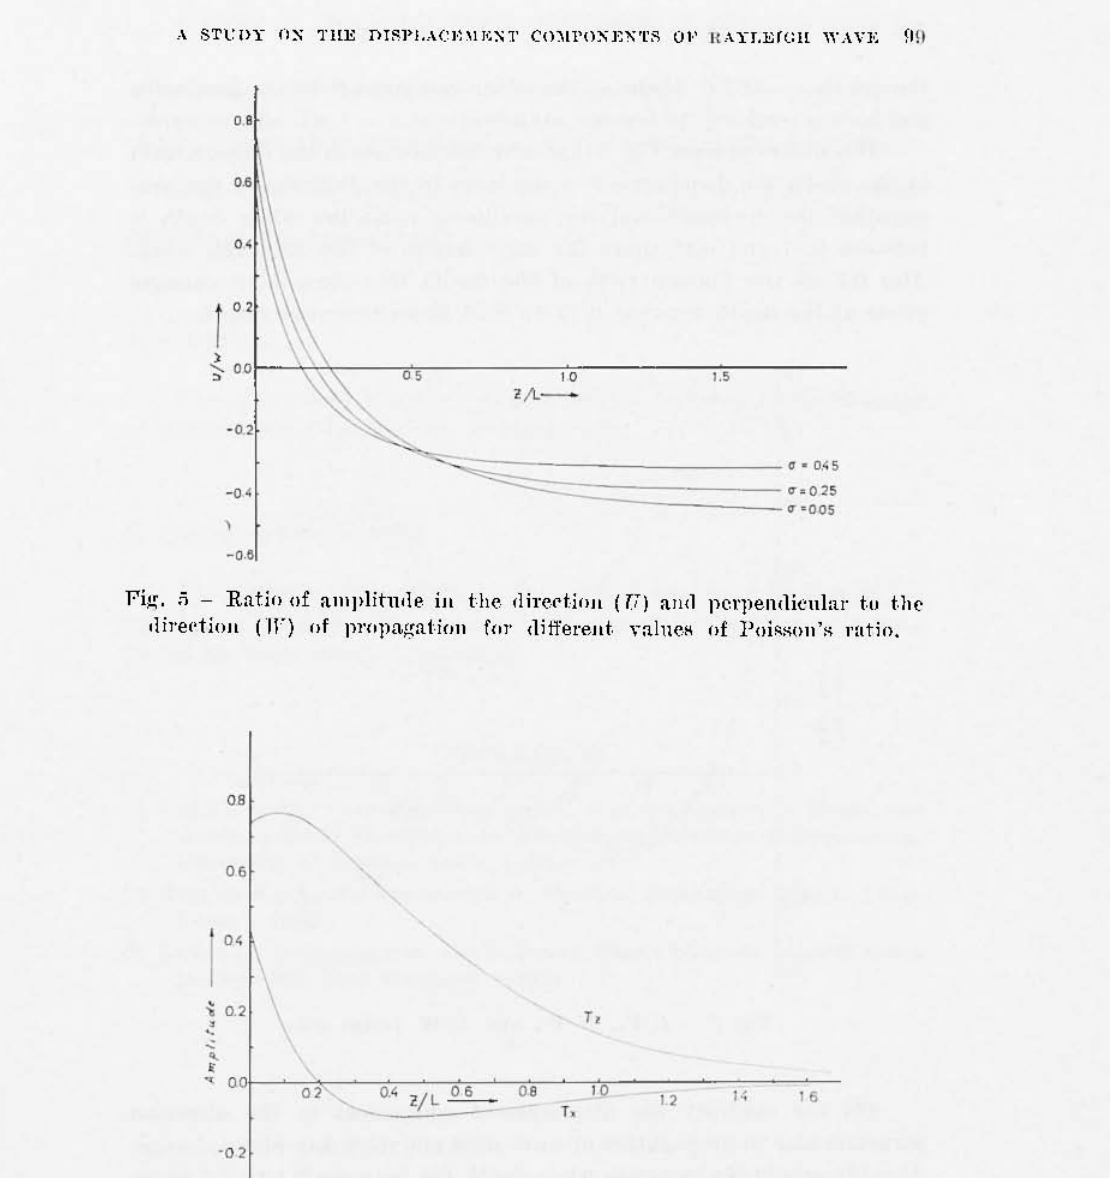
Fig. ti - Coetlidellt of (le{'a~- of (lispla{'cllOent in lite (1irediull of prop:l gat.ion (~·x) arul in thc ,lirf'.t'tion l'erpeJl(lio-nlar to propagat.ion